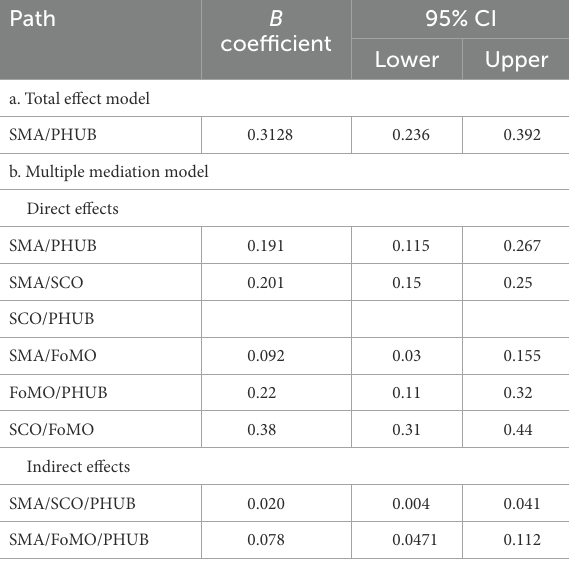
TABLE 3 Path analysis of the multiple mediation model.